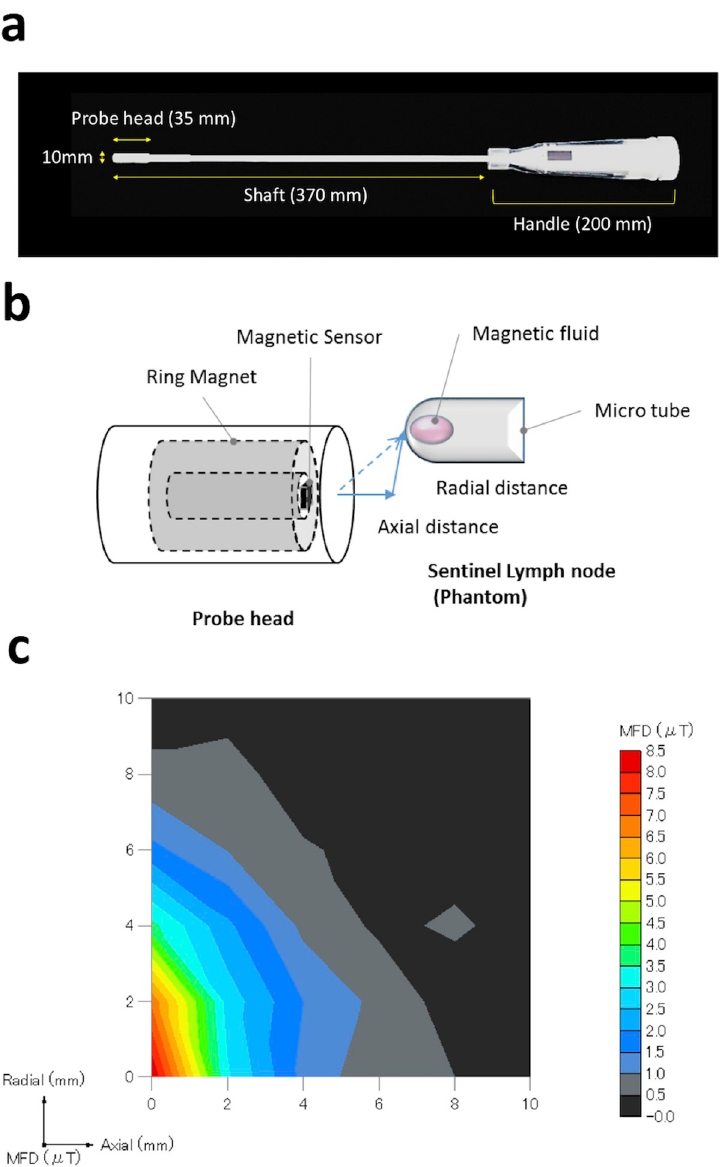
Fig 2. The modified magnetic probe. ( a ) Photograph of the laparoscopic magnetic probe. The display and battery are contained in the handle, which has a sterilisable plastic cover. ( b ) Scheme of the experimental procedure for evaluating the detection range of the laparoscopic magnetic probe. (c) Map of the sensor output obtained with a magnetic fluid sample scanned in the radial–axial plane. MFD: magnetic flux density.